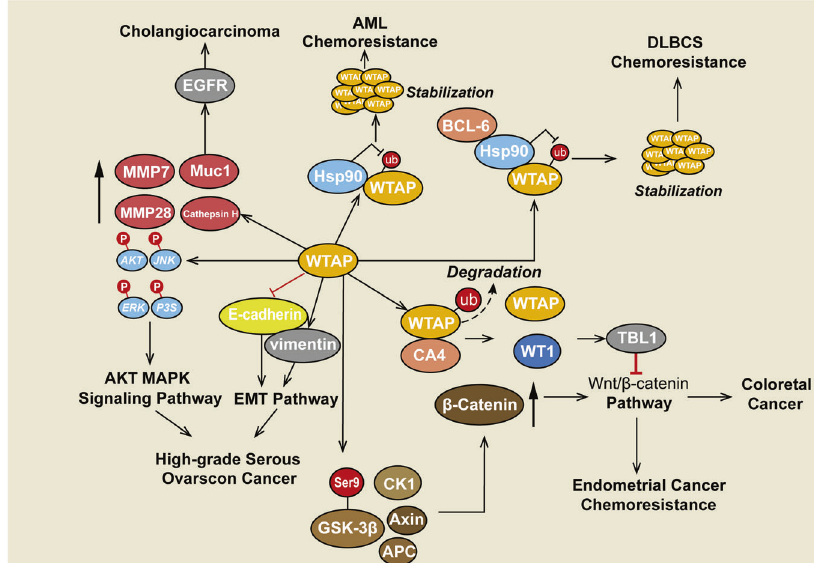
Fig. 6 Other functions of WTAP in cancers. WTAP regulates the differential expression of oncogenes and tumor suppressor genes at the non- posttranscriptional level. WTAP induces the expression of Muc1, which regulates EGFR activity in cholangiocarcinoma. Hsp90 forms a complex with WTAP and stabilizes its protein level to promote chemoresistance in AML. In DLBCL, Hsp90 also stabilizes the WTAP protein, which forms a complex with BCL6. In colorectal cancer, CA4 interacts with WTAP and promotes its degradation in a polyubiquitination-dependent manner so that WT1 is released from the WT1-WTAP complex, resulting in the induction of transducin β -like protein 1 (TBL1) and the degradation of β -catenin, which blocks the Wnt pathway. WTAP was found to facilitate the nuclear translocation of β -catenin and enhance the phosphorylation of GSK3b at Ser9, which induced chemoresistance to cisplatin in endometrial carcinoma by activating the Wnt/ β -catenin pathway. Additionally, WTAP was found to regulate the expression of the EMT-related proteins E-cadherin and vimentin. Furthermore, WTAP is involved in the activation of the AKT and MAPK pathways. Overall, WTAP contributes to cell proliferation, apoptosis, invasion, metastasis, and chemo- or radioresistance in different